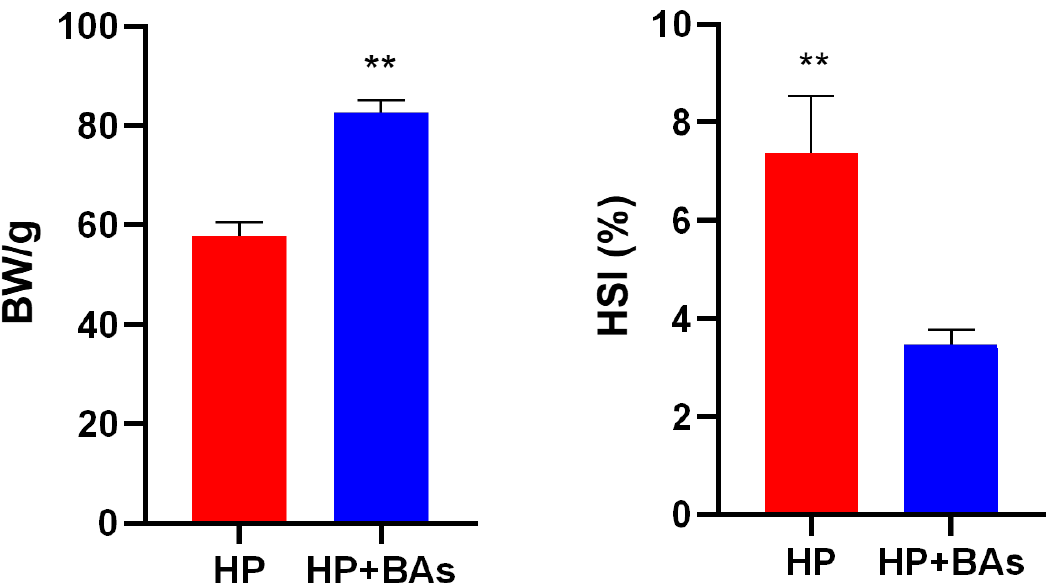
Figure 2. Supplement bile acids to high plant protein feed improved the growth performance and reduced the hepatosomatic index (HSI) in common carp ( Cyprinus carpio ). (Statistically significant results are indicated by asterisks (**, p < 0.01), n = 7.